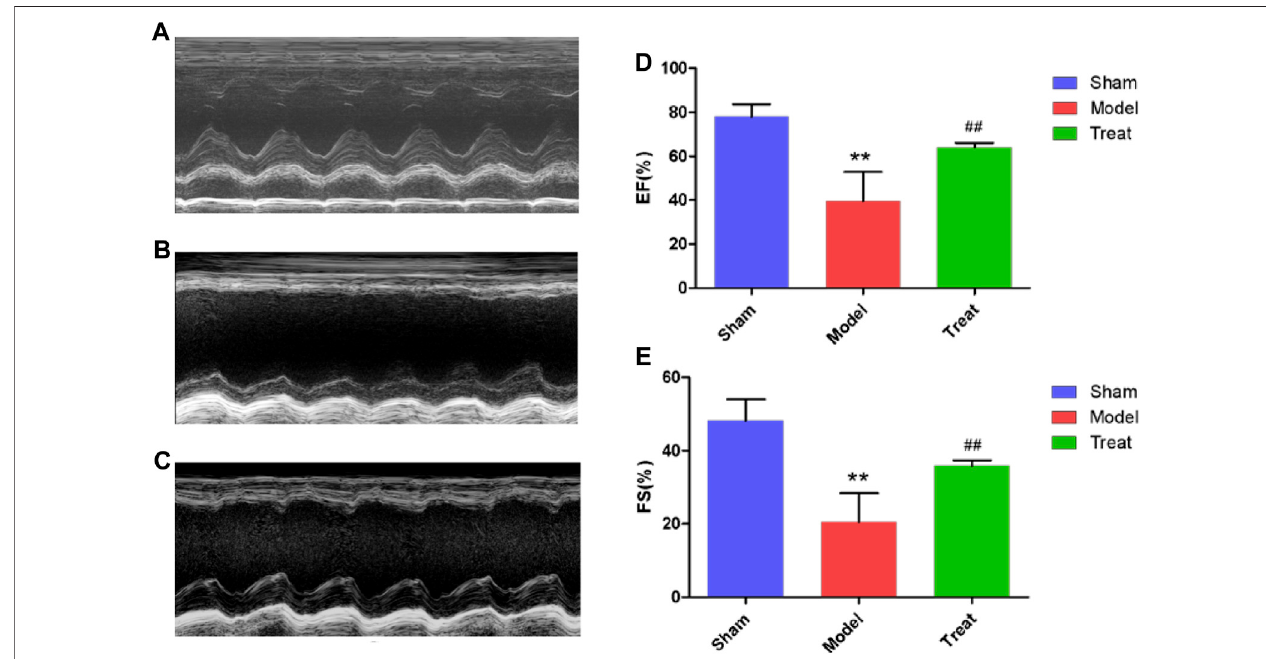
FIGURE1|(A,BandC) Representativeimagesofechocardiography (DandE) EFandFSweremeasuredbyechocardiography.Datawereexpressedasmean ± SD ( n (cid:1) 6), ** p < 0.01 compared with the Sham group, ## p < 0.01 compared with the Model group.